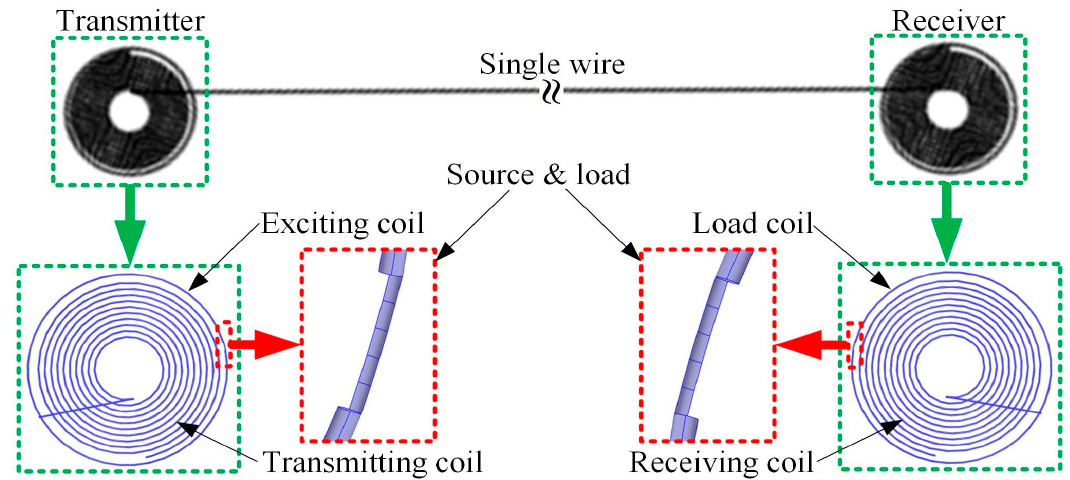
Figure 3. Simulation model of the single-wire power transfer system.